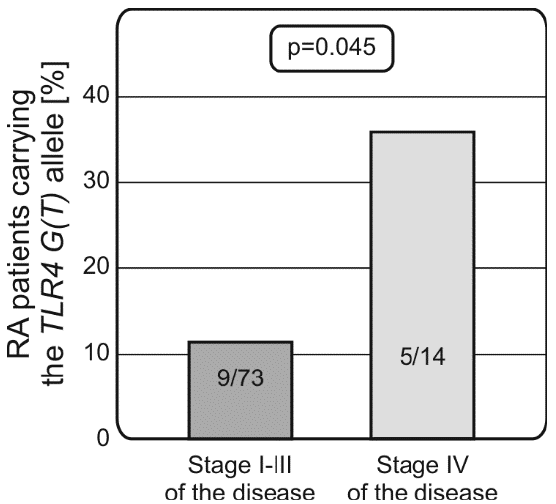
Figure 2. Both nonsynonymous TLR4 (rs4986790; Asp299Gly, 13,843 A > G; and rs4986791, Thr399Ile, 14,143 C > T) polymorphisms are associated with predisposition to stage IV of RA. The presence of the TLR4 rs4986791 G (rs4986790 T) allele was more frequently detected in patients presenting with stage IV of the disease.